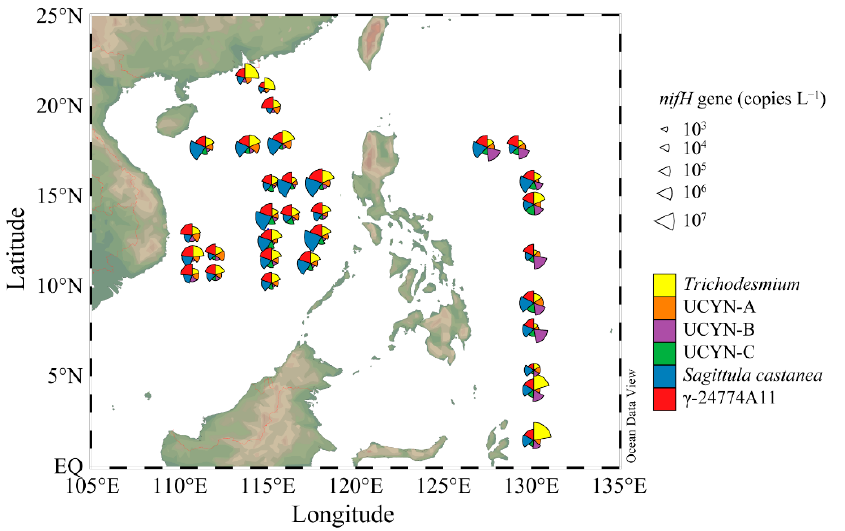
Figure 4. The nifH gene copies and distributions of representative genera phylotypes in different regions.